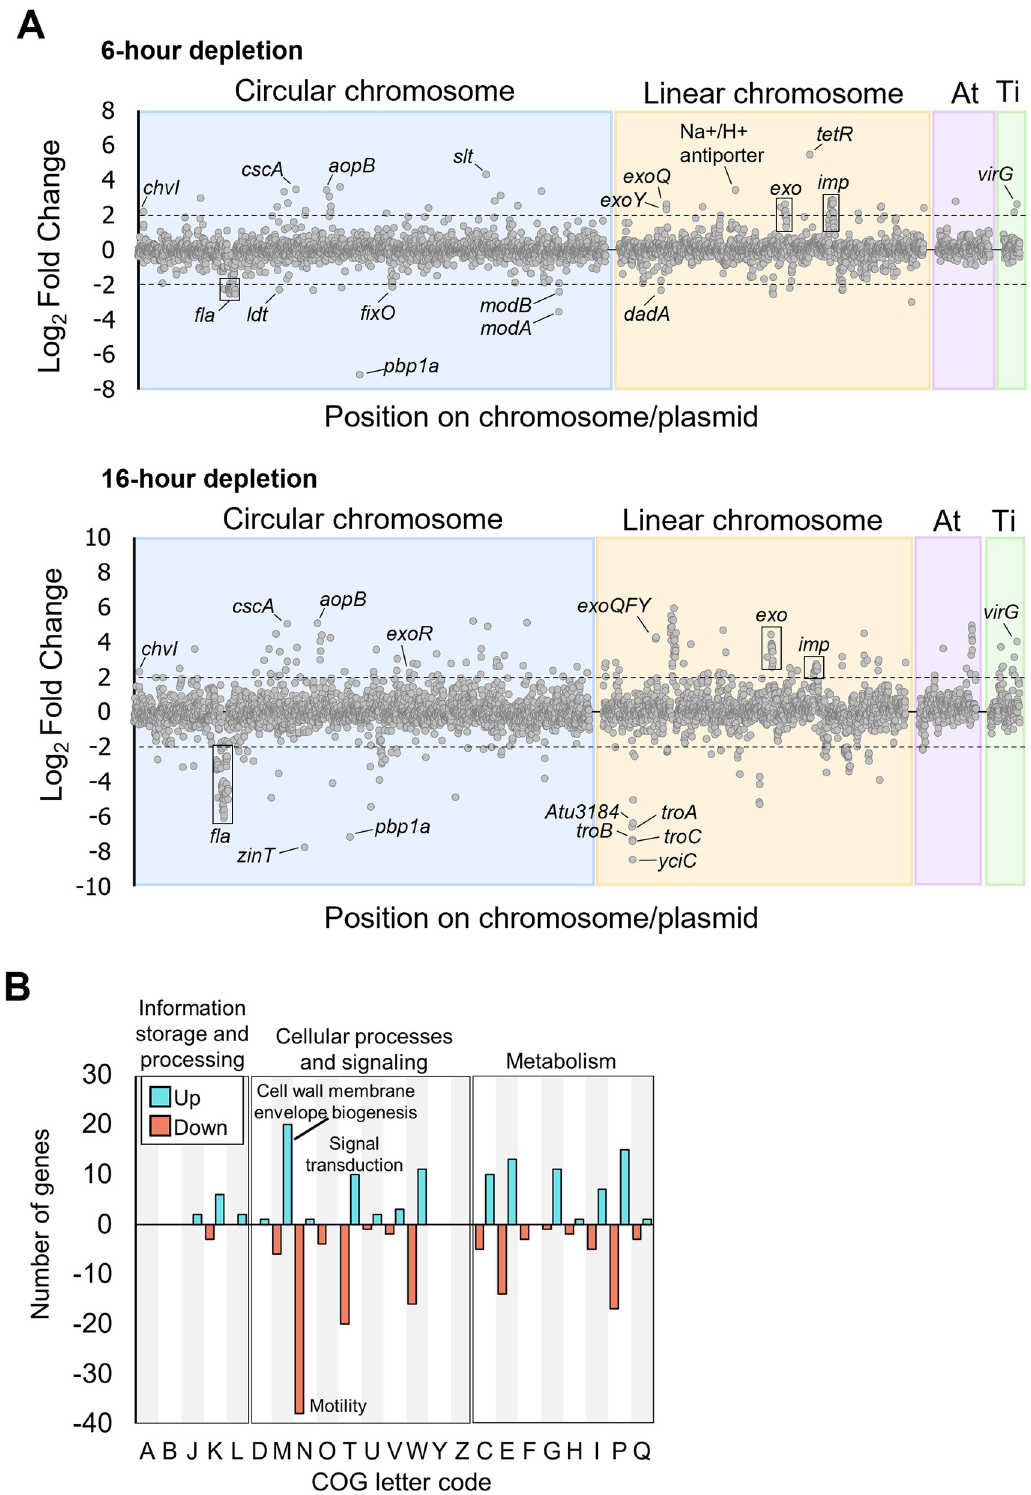
Fig 2. Analysis of the PBP1a depletion transcriptomes by RNA-seq. A. Plots comparing Log2Fold Change of the + PBP1a transcriptome to that of the—PBP1a 6-hour transcriptome and to that of the 16-hour depletion. Gray dots represent a single transcript, and the dotted lines represent +/- 2.0 Log2Fold Change threshold. Plots are delimited by chromosome and mega plasmid. B. COG categorical analysis of the 16-hour depletion of PBP1a. Pink, downregulated; Cyan, upregulated. https://doi.org/10.1371/journal.pgen.1010274.g002 PLOS Genetics | https://doi.org/10.1371/journal.pgen.1010274 December 8,